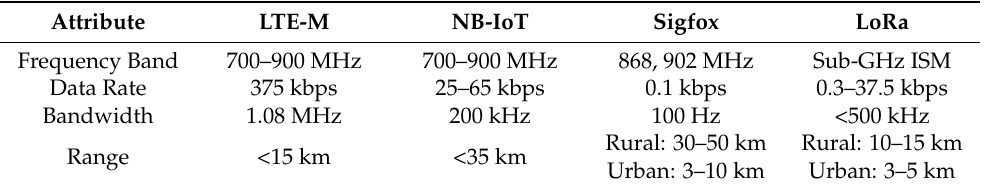
Table 1. Attributes for long-range technologies for the Internet of Things (IoT).